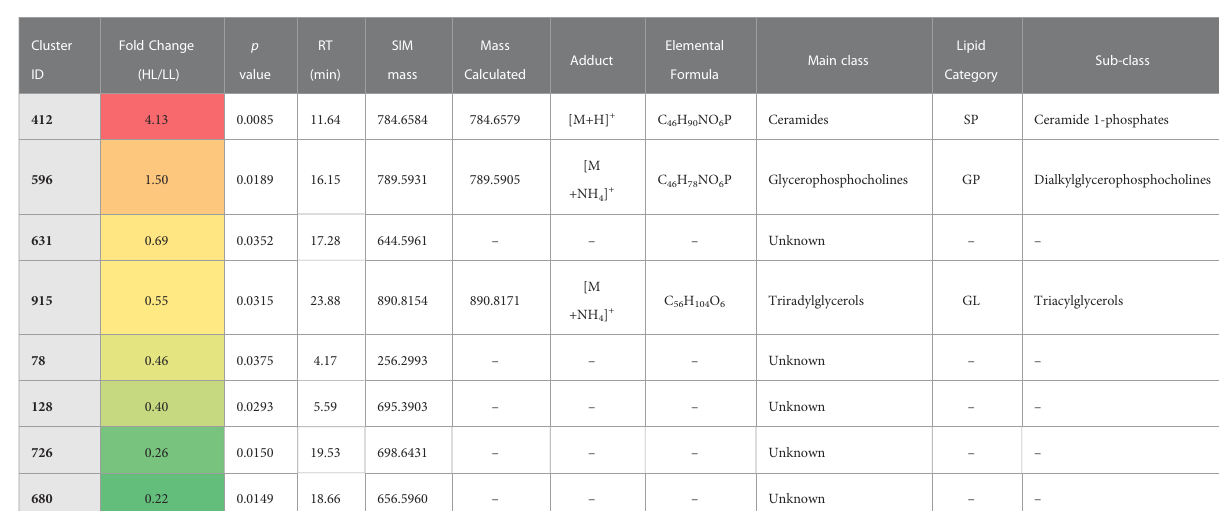
TABLE 1 List of putatively annotated seed lipids with statistical differences between low light (LL) and high light (HL) microclimates at green stage of berry development (Student ’ s t-test, p ≤ 0.05).